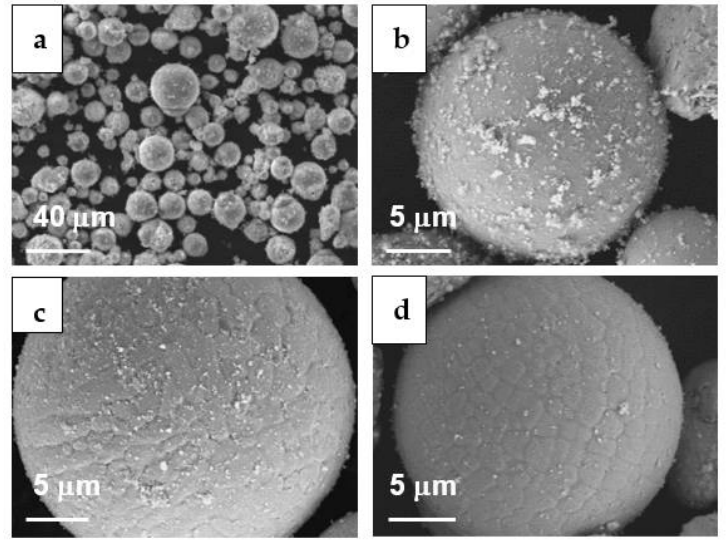
Figure 5. SEM-images of Ni 36 Al 27 Co 37 powder after plasma spheroidization: ( а ) magnification 1000; ( b ) magnification 10,000 ( c ) after PS and air classification and ( d ) after PS. air classification and ul- trasonic treatment.